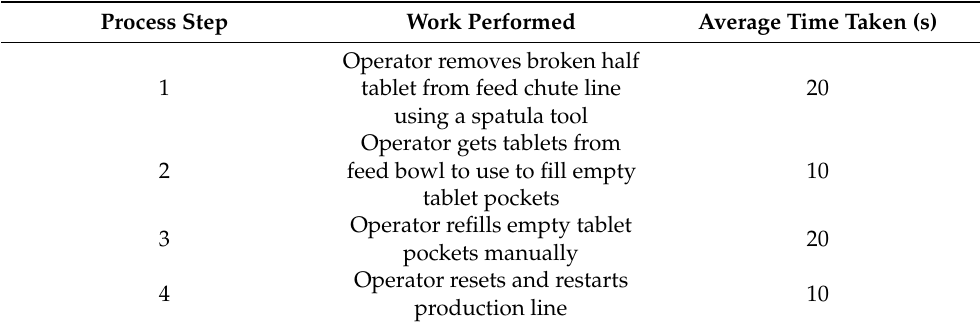
Table 1. Standard work practice for line stops describing the exact work steps required to resolve a tablet feed line stop within 60 s. Until a root cause and corrective action for line feed stops are identified, standard work for clearing stops to minimize production disruption is